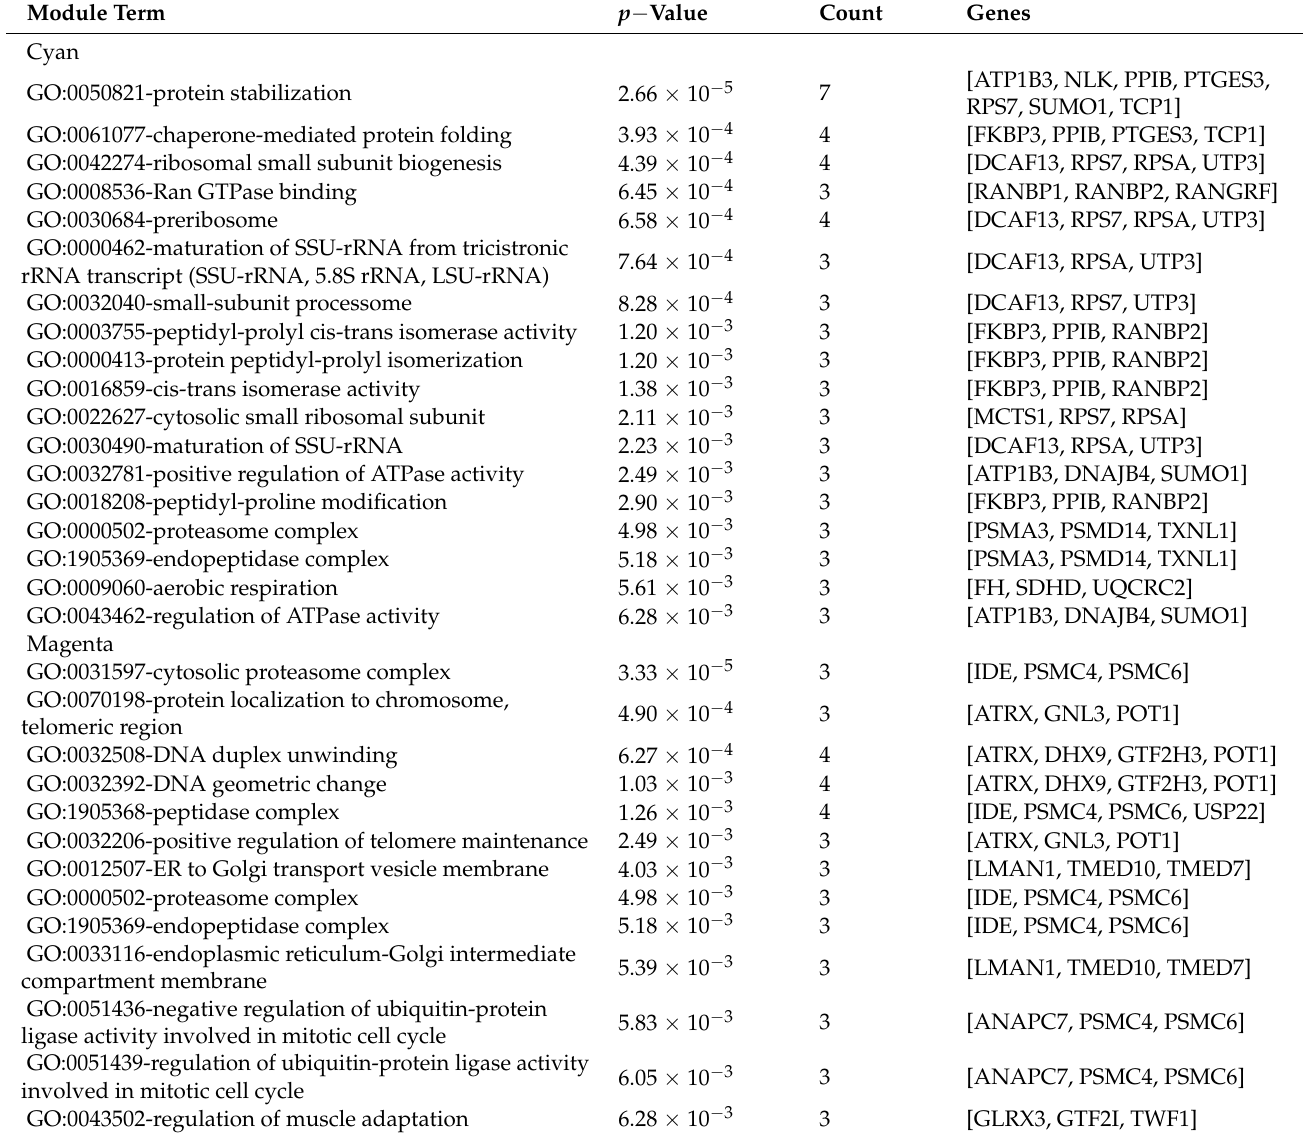
Table 1. List of significant GO terms for the cyan and magenta modules identified by the